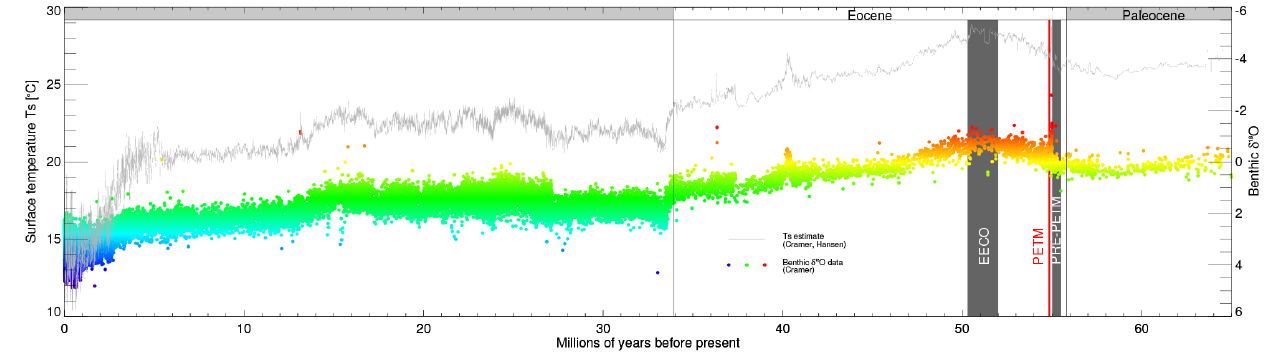
Figure 2. The three DeepMIP palaeointervals – EECO (grey shaded region), pre-PETM (grey shaded region), and the PETM (vertical red line). Also shown for context is the climate evolution over the last 65 million years, as expressed by the benthic oxygen isotope record of Cramer et al. (2009) (coloured dots), and a global annual mean surface temperature record produced by applying the methodologies of Hansen et al. (2013) to the Cramer et al. (2009) δ 18 O benthic data, and applying a 10-point running average (grey line). Note that the formal definition of the start and end date of each time period is still to be finalized. Table 1. Summary of simulations associated with DeepMIP, including two relevant simulations from CMIP6 ( piControl and abrupt-4xCO2 ), the three standard simulations ( deepmip-stand-X ), and some of the suggested sensitivity studies ( deepmip-sens-X